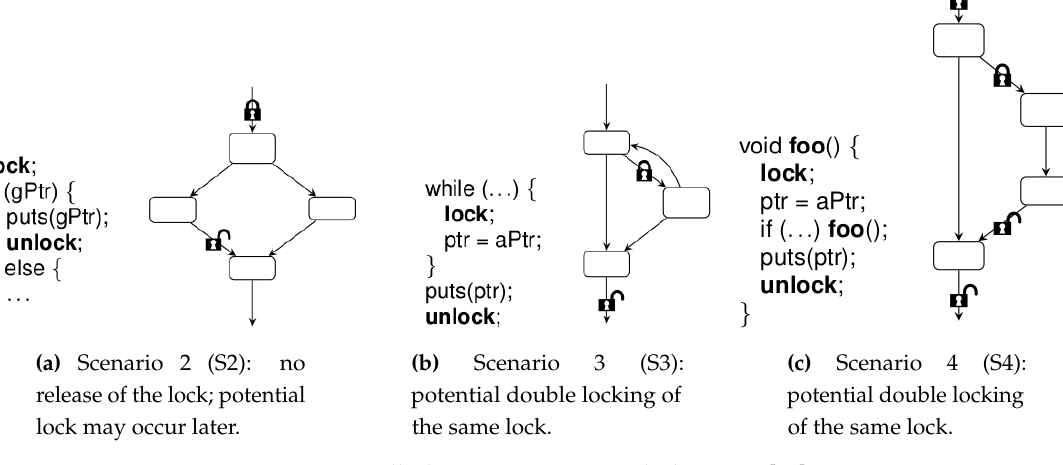
Figure 1. Deadlock scenarios using one lock. Source [16].